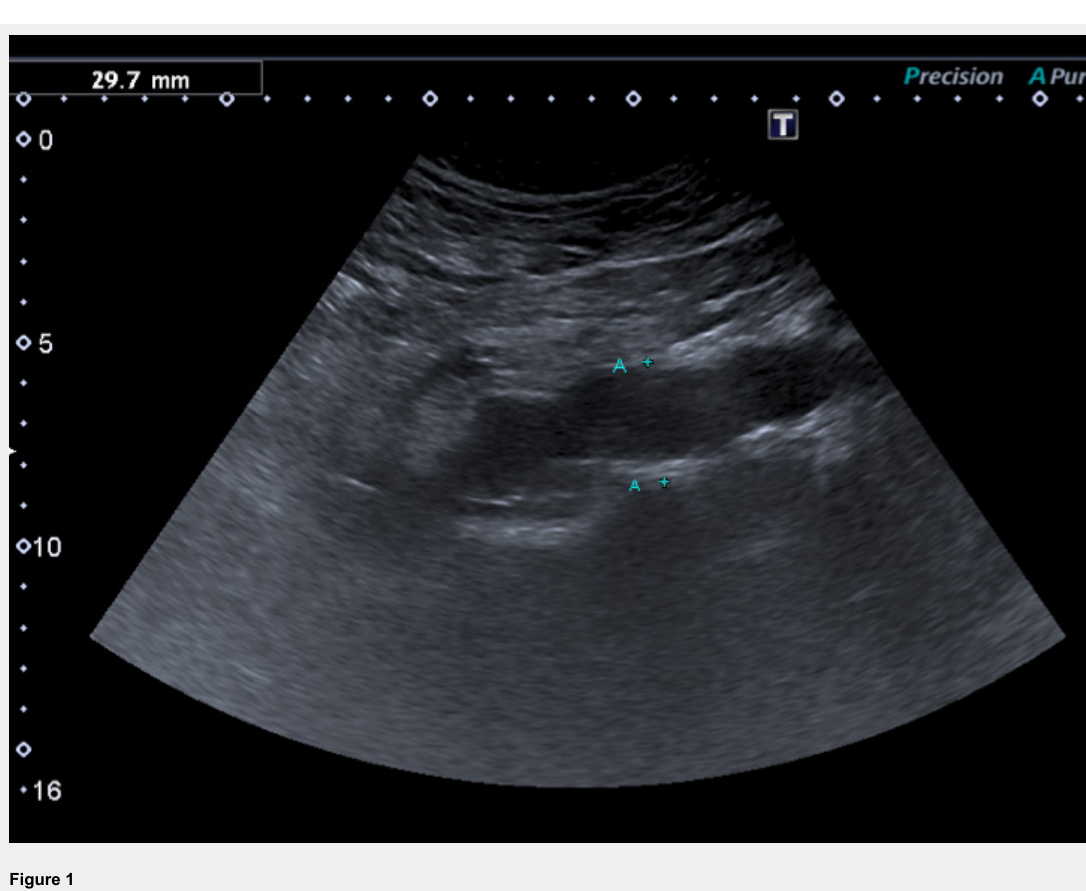
Figure 1 Previously undiagnosed small abdominal aortic aneurysm detected on vascular duplex ultrasound in a 62-year-old smoker with erectile dysfunction, otherwise asymptomatic regarding cardiovascular